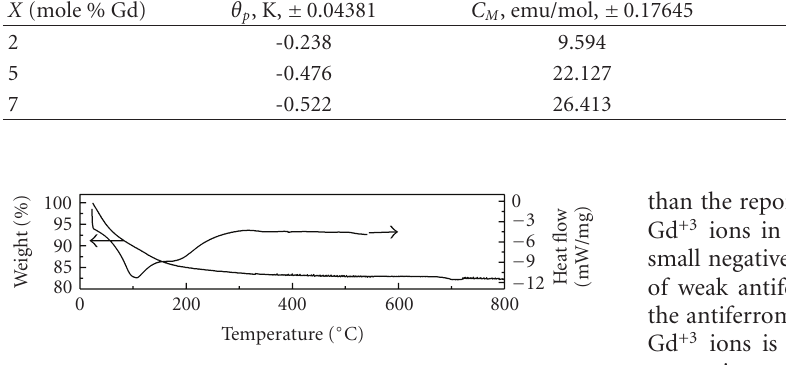
Figure 5: DSC and DTG data for the 5% Gd 3+